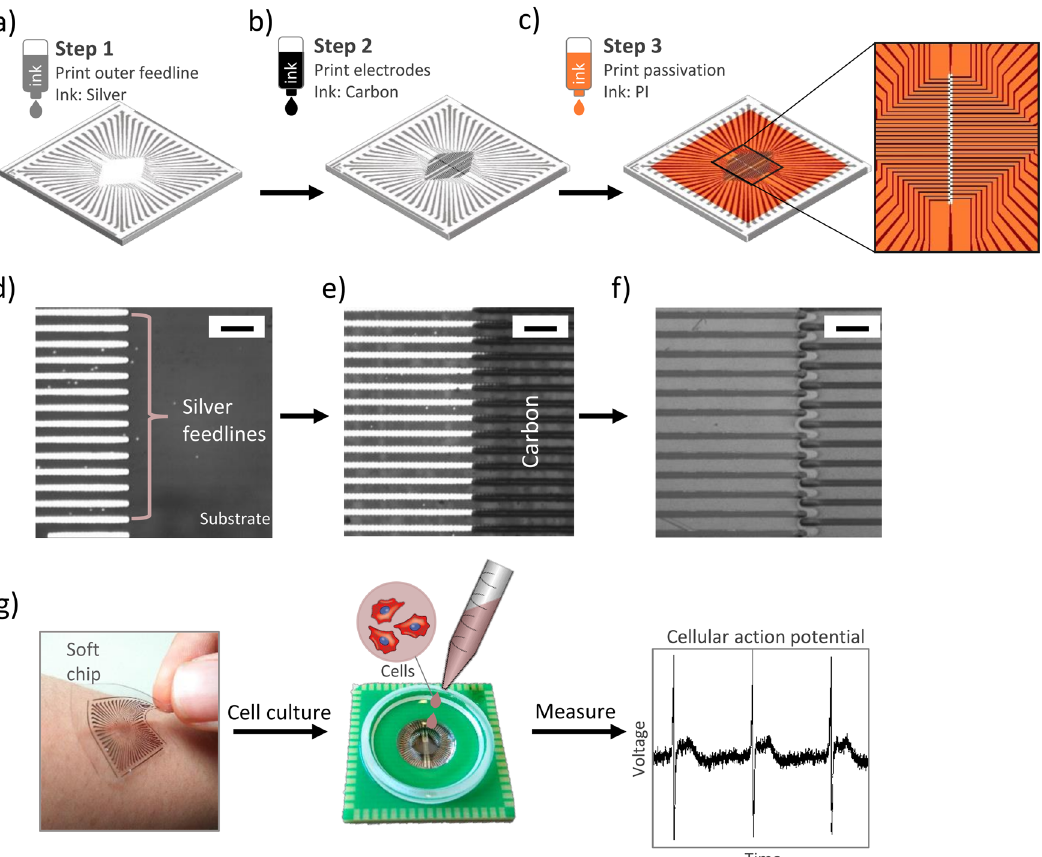
Fig. 1 Sketch of the device principle and printing procedure. a Step 1: outer feedlines are printed with a silver nanoparticle ink on a 12 × 12 mm² substrate. b Step 2: inner feedlines and MEAs are printed with carbon nanoparticle ink. c Step 3: A 9 × 9 mm² passivation layer is printed with polyimide ink (PI). d – f Microscopic images of the successive printing process of a carbon MEA on PDMS subsequently depositing d silver ink, e carbon ink, and f PI ink. Scale bars represent 200 μ m. g Principle of the recording of action potentials from electrogenic cells using the printed soft